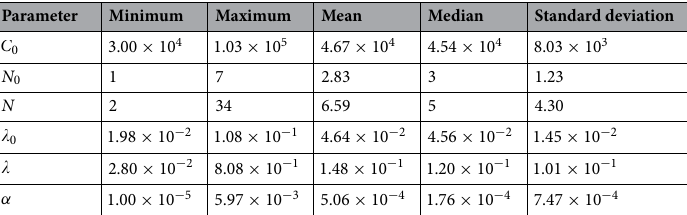
Table 3. Summary statistics of OT-I clonotype posterior distributions for the multi-stage model.